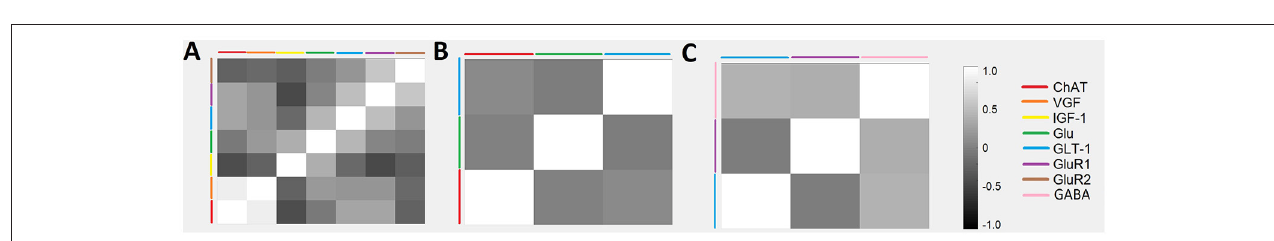
FIGURE 4 | Temporal relationships between non-inflammatory regulators of astrocytes visualized as a cross-correlation matrix. Average concentrations of glutamate, GABA, and related cytokines for ALS mice were normalized to wild-type mice with data aggregated across three temporal stages: (A) 0–96 days, (B) 97–116 days, and (C) 117 + days. Highly positive correlations were found between VGF and ChAT at 0–96 days. Note that only factors with sufficient sample sizes (calculated using standard statistical power analysis) were included.